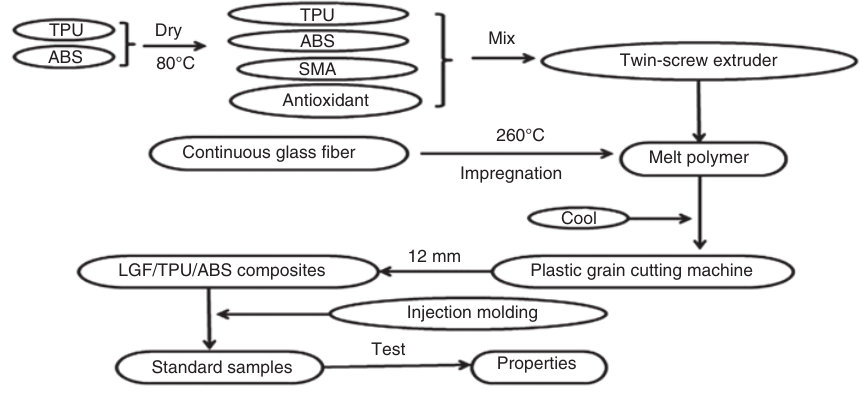
Figure 1 Preparation process schematic of the LGF/TPU/ABS